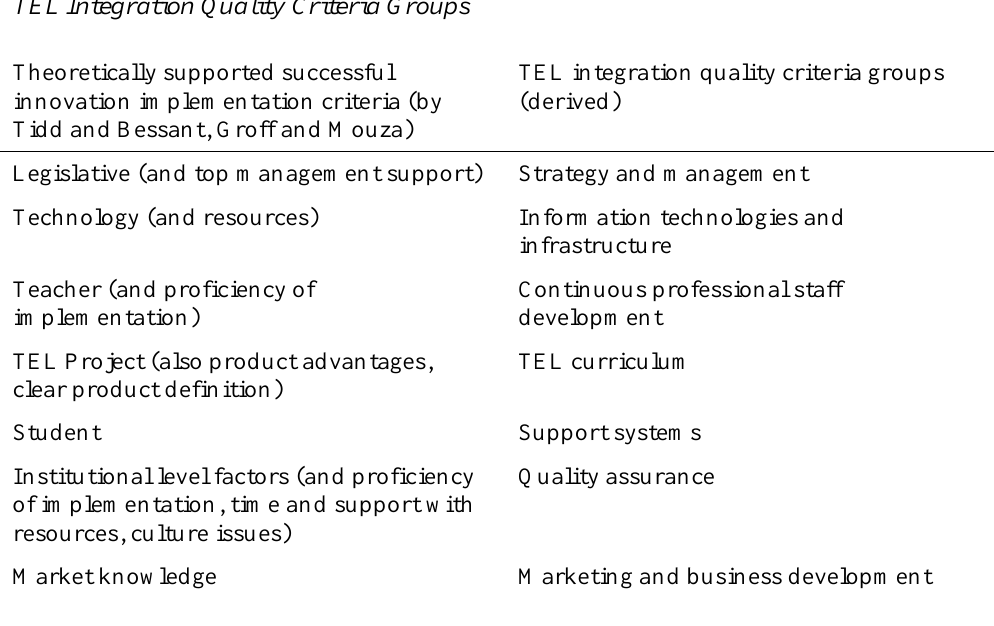
TEL Integration Quality Criteria Groups Theoretically supported